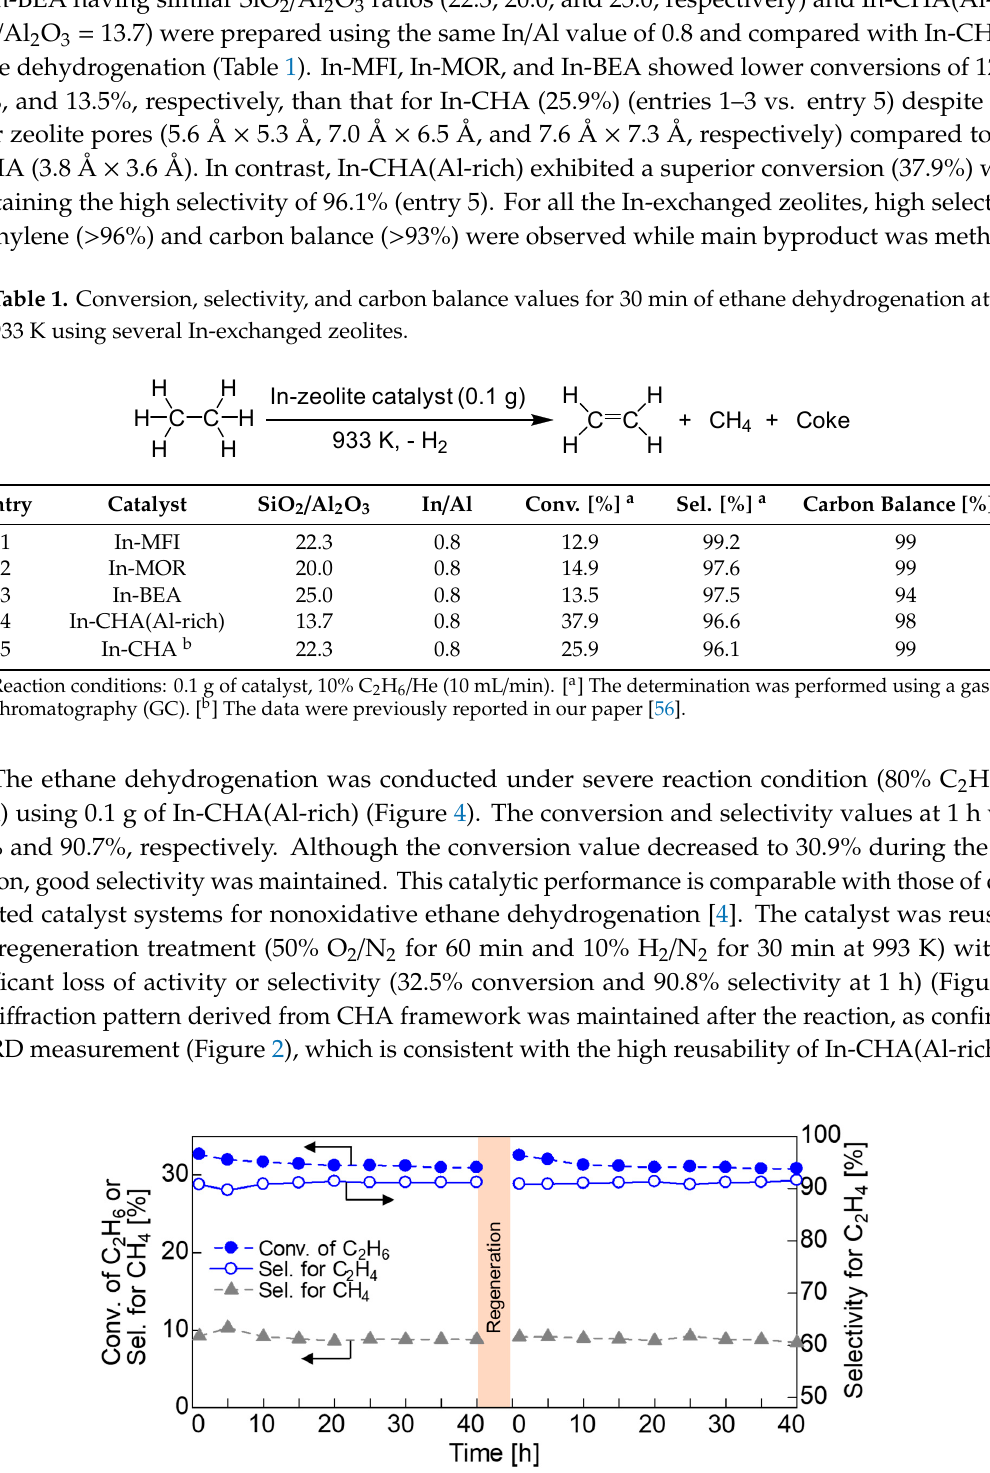
Figure 3. Ammonia temperature-programmed desorption (NH 3 -TPD) profiles for H-CHA and different In-CHA samples.